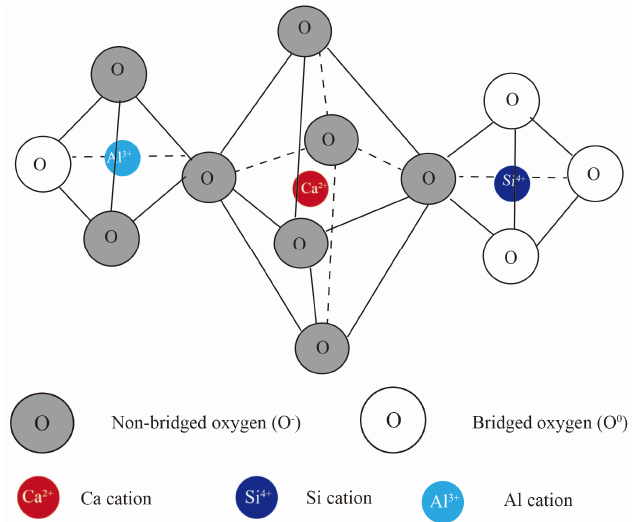
Figure 13. Schematic diagram of the molten slag structure.